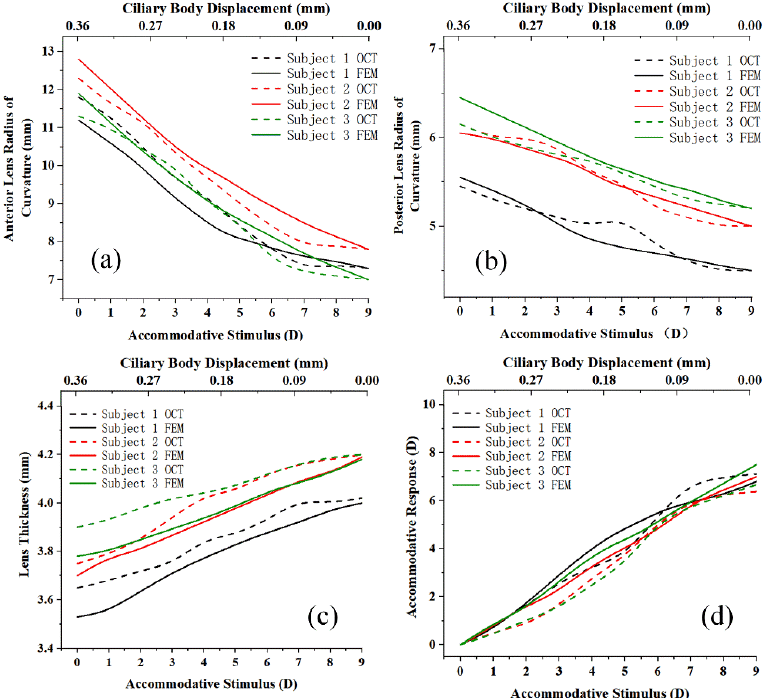
Figure 10. The verification of accommodation accuracy of personalized lens finite element model. Comparison of four parameters between the finite element model and the real lens in the process from the no-accommodation state to the maximum-accommodation state. ( a – d ) are curvature radius of the anterior and posterior surfaces, thickness, and the accommodative response of the lens, respectively. FEM: finite element model. OCT: Optical Coherence Tomography.